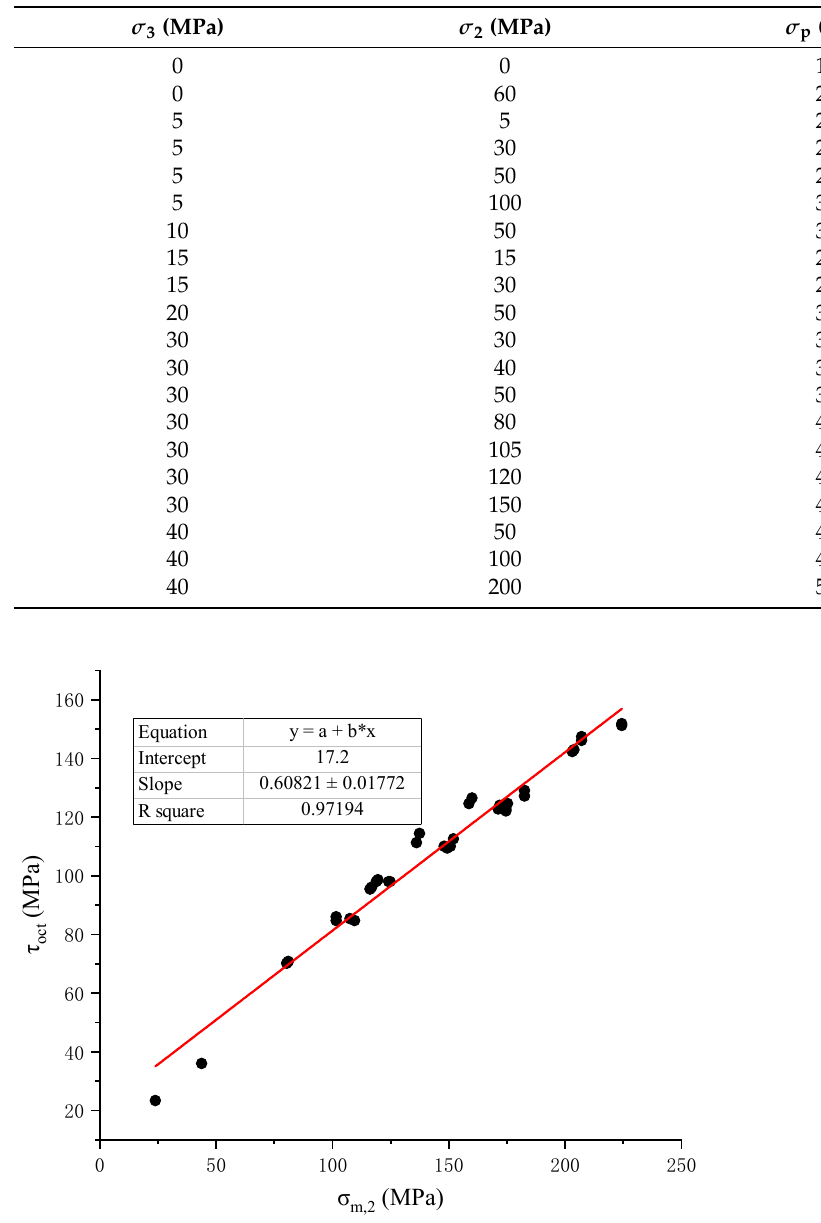
Table 2. Rock peak stress under true triaxial stress.